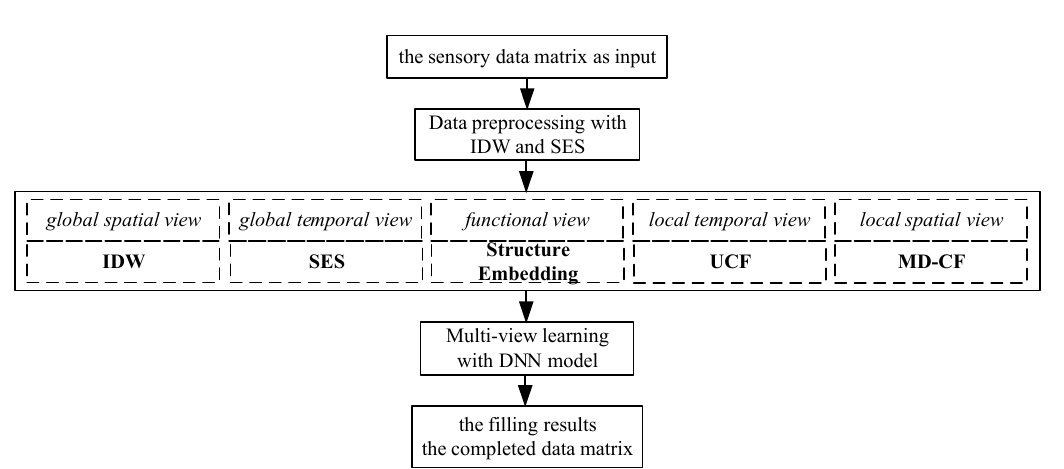
Figure 4. Framework of proposed DNN-multi-view learning method (MVL) method.